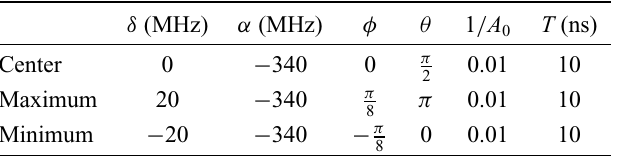
TABLE II. The parameter range for the optimization of the single-qubit gates R 1 (θ) and R 2 (θ) as given in Fig. 5. In this case, we not only vary the detuning but also the angles of the gates and the phase factor φ .